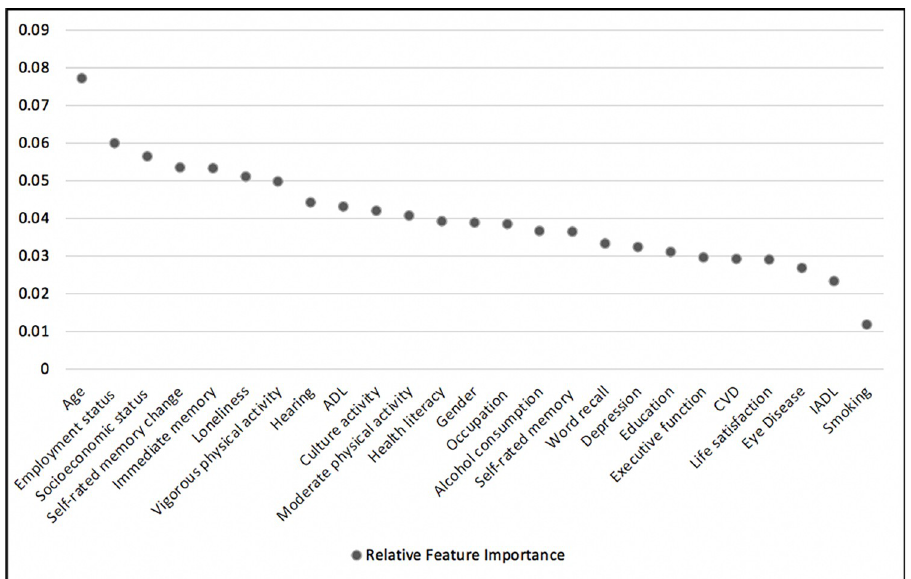
Fig 4. Top 25 ranked features with their score when predicting major cognitive decliners vs minor decliners using fitted XGBoost.